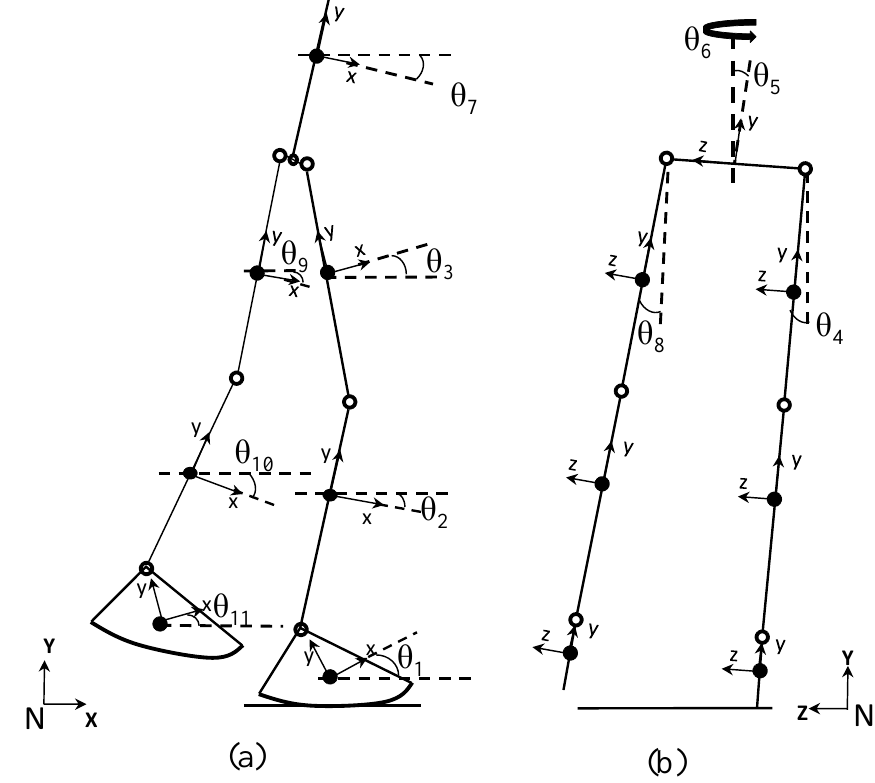
Figure 1. Stick figures showing the angles in the (a) sagittal and (b) frontal planes. All angles are measured with respect to N. (HAT segment is not shown in the frontal plane b